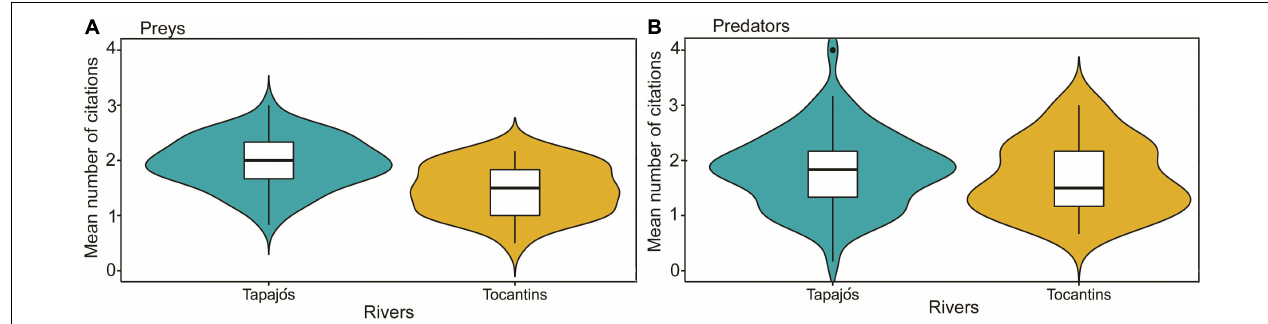
FIGURE 3 | Comparison of the average number of fishers’ citations between the Tapajós and Tocantins rivers regarding the number of (A) fish prey ( t = 4.96, df = 97, p < 0.01) and (B) fish predators ( t = 0.88, df = 97, p = 0.38). Boxplot indicates the median (dark line inside box) and quartiles (25 and 75%, outer lines of the box). Data distribution is indicated by violin-colored